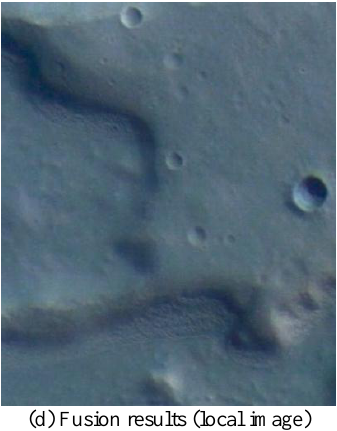
Figure 6. Image fusion results of test